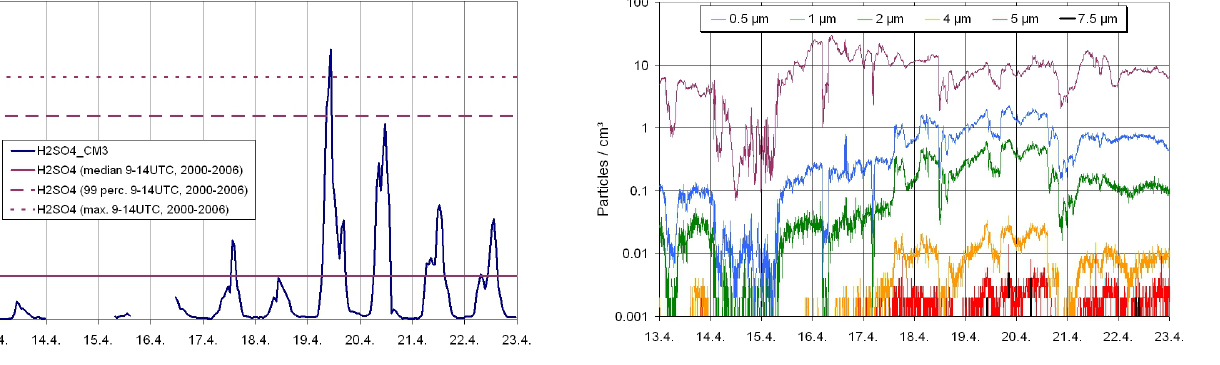
Fig. 5. Sulfuric acid (H 2 SO 4 ) measurements at the GAW Global Station Zugspitze/Hohenpeissenberg, platform HPB at 980m ele- vation as derived from a Chemical Ion Mass Spectrometer (CIMS). The continuous and dashed purple lines indicate the median, the 99- percentile and the maximum observed (year 2000–2006) values of the H 2 SO 4 mixing ratios at Hohenpeissenberg.